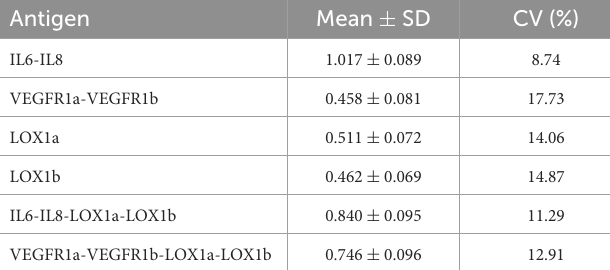
(Table 2), so that Mann-Whitmey U -test was used to examine the differences in plasma IgG levels between the patient group and the control group. Because six individual antigens were tested in the present study, the significance level was set at p < 0.008 (0.05/6) based on the Bonferroni correction. Receiver operating characteristic (ROC) analysis was performed to work out the area under the ROC curve (AUC) with calculation of a sensitivity against the specificity of > 95% for each IgG